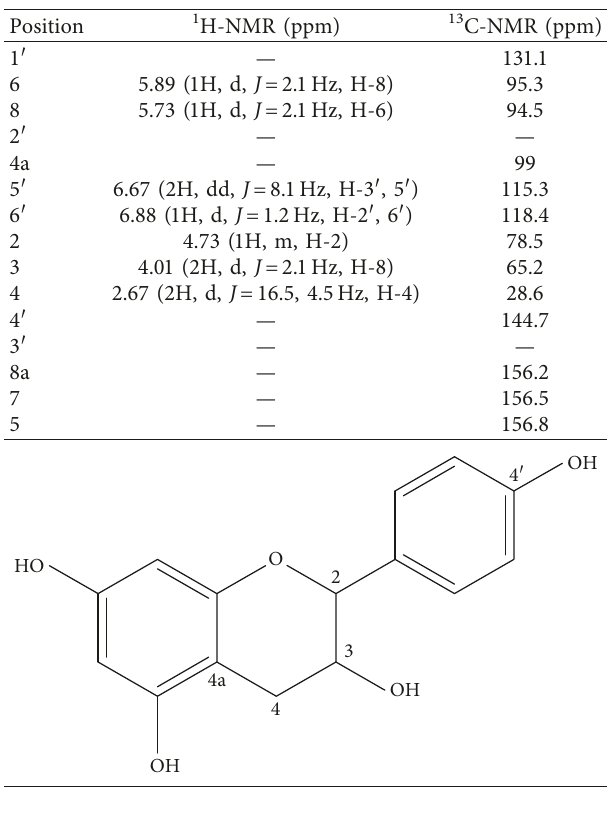
Table 4: Zone of bacterial growth inhibition (mm) for crude extract and isolated compounds from the stem bark of E. schemperi . Sample